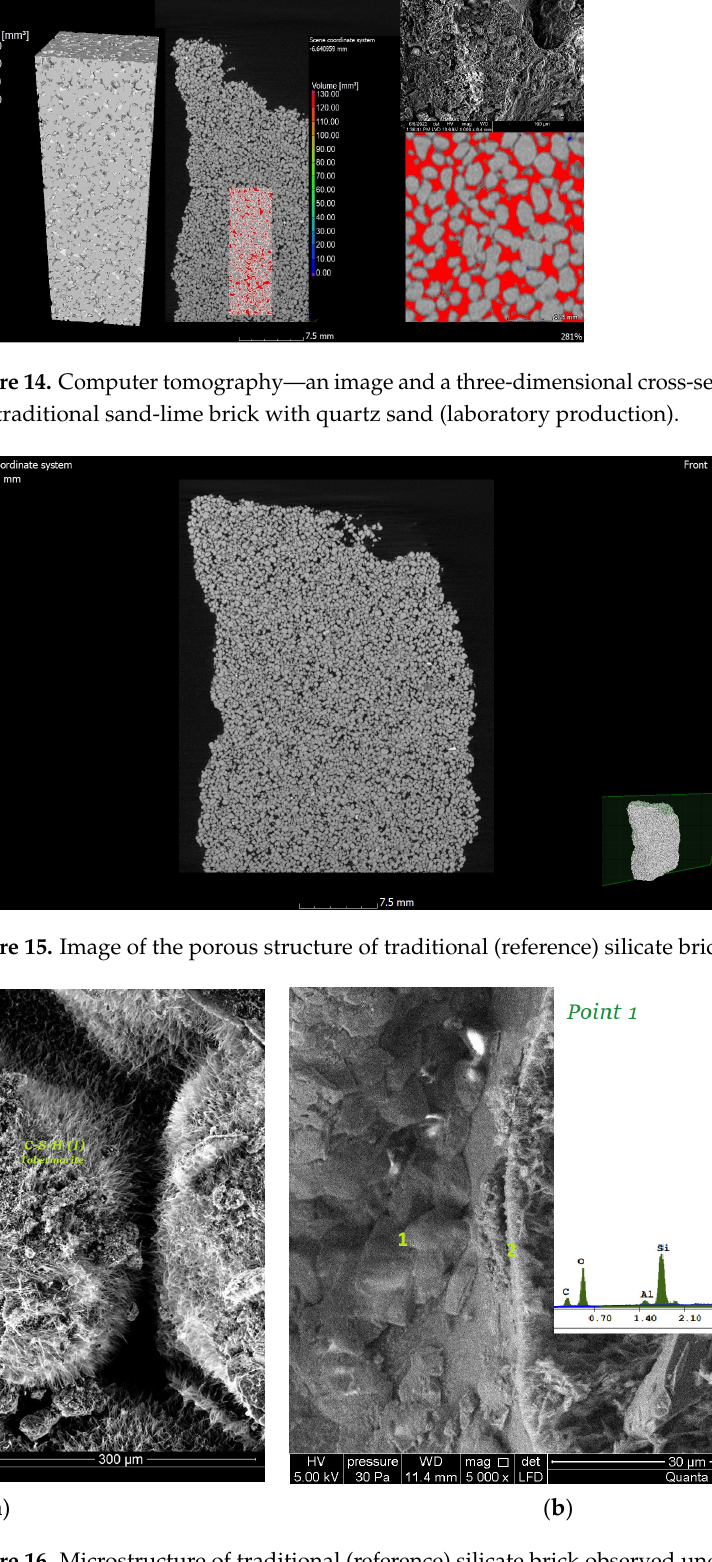
Figure 17. Computer tomography with a photograph of the analyzed laboratory brick and an area of microstructure (SEM, 50 μ m, brick 5 × 5 × 5 cm) of brick modified by glass sand.